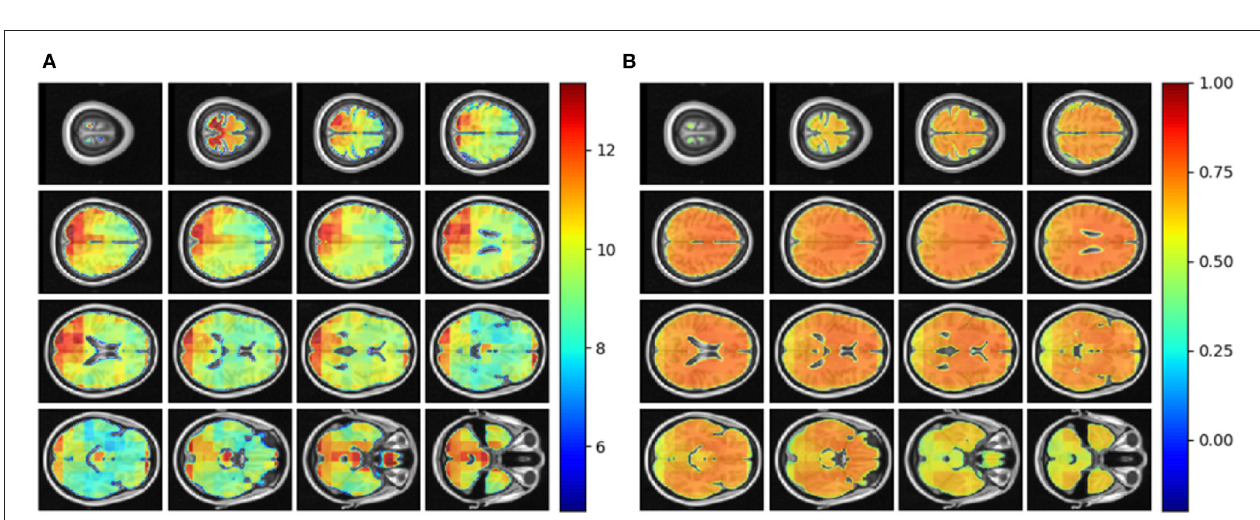
FIGURE 4 | (A) Axial slices showing the spatial heterogeneity in unadjusted across participants voxel-level MAE values; (B) Pearson’s correlation coefficient between chronological age and voxel-level predicted brain-age (unadjusted) across